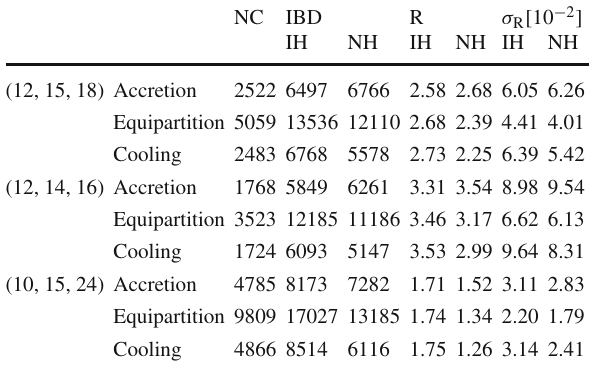
Table 3 Numbers of IBD and NC events in three specific scenarios listed in Table 1 for different sets of the average mean energies (< >, < E ¯ ν >, < E ν >) at LENA E ν e e x